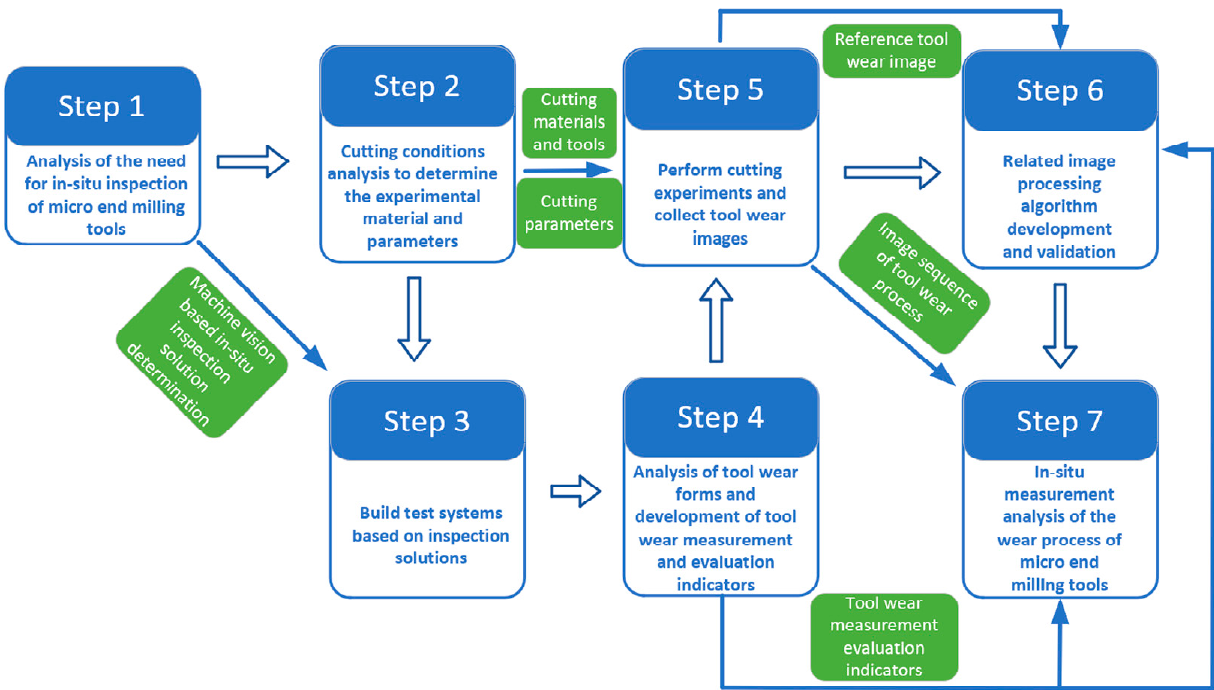
Figure 1. The block diagram of the proposed research.